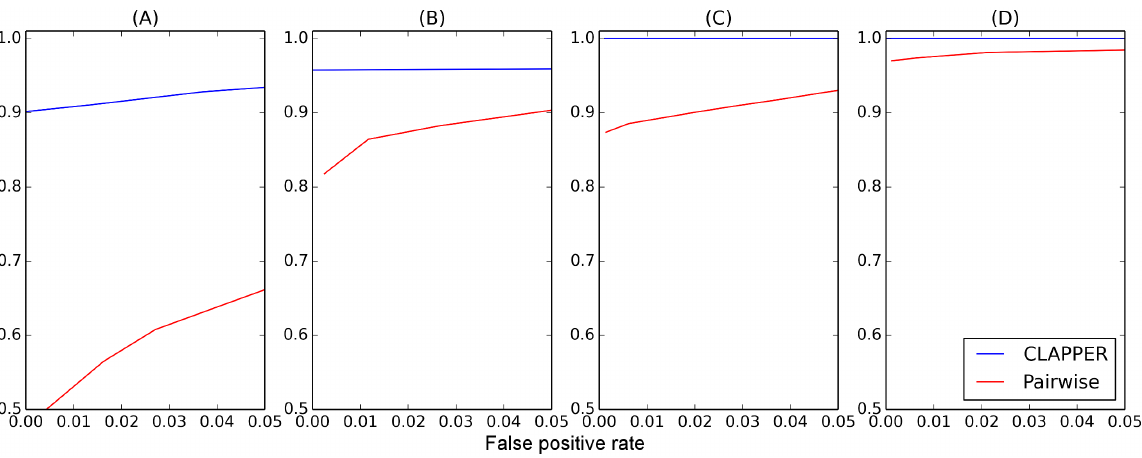
Fig 6. ROC curve for detecting relativesin a sample: Pairwise vs. CLAPPER. (A) simulationA; (B) simulationB; (C) simulationC; (D)